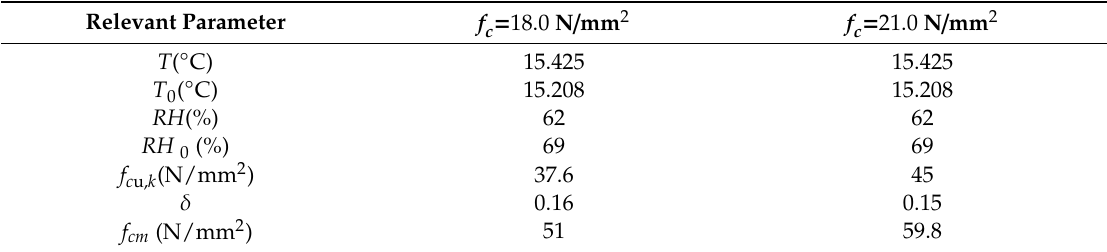
Table 1. Relevant parameters calculating the carbonation depth in Yokohama,